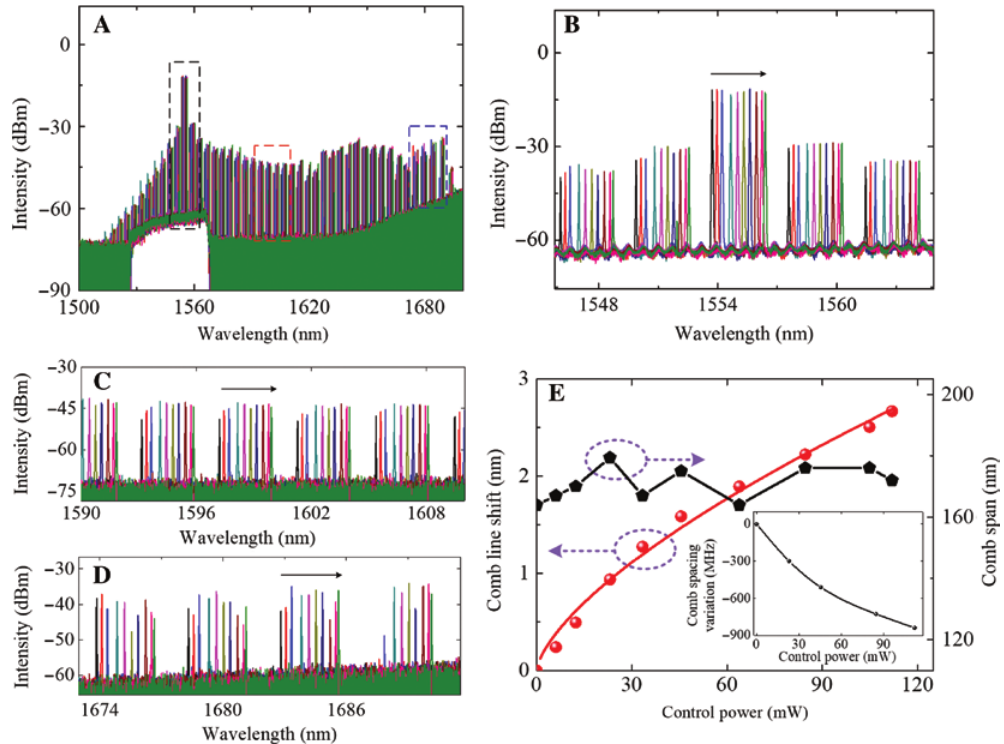
Figure 6: Controllable Raman-Kerr frequency comb. (A) Tuning of the Raman-Kerr frequency comb line with the increase of the control power. (B) (Black line frame in Figure 6A), (C) (red line frame in Figure 6A), and (D) (blue line frame in Figure 6A) Zoom-in spectra of Figure 6A. (E) Comb line shift (red line), comb span (black line), and comb spacing variation (the inset) vs. the control